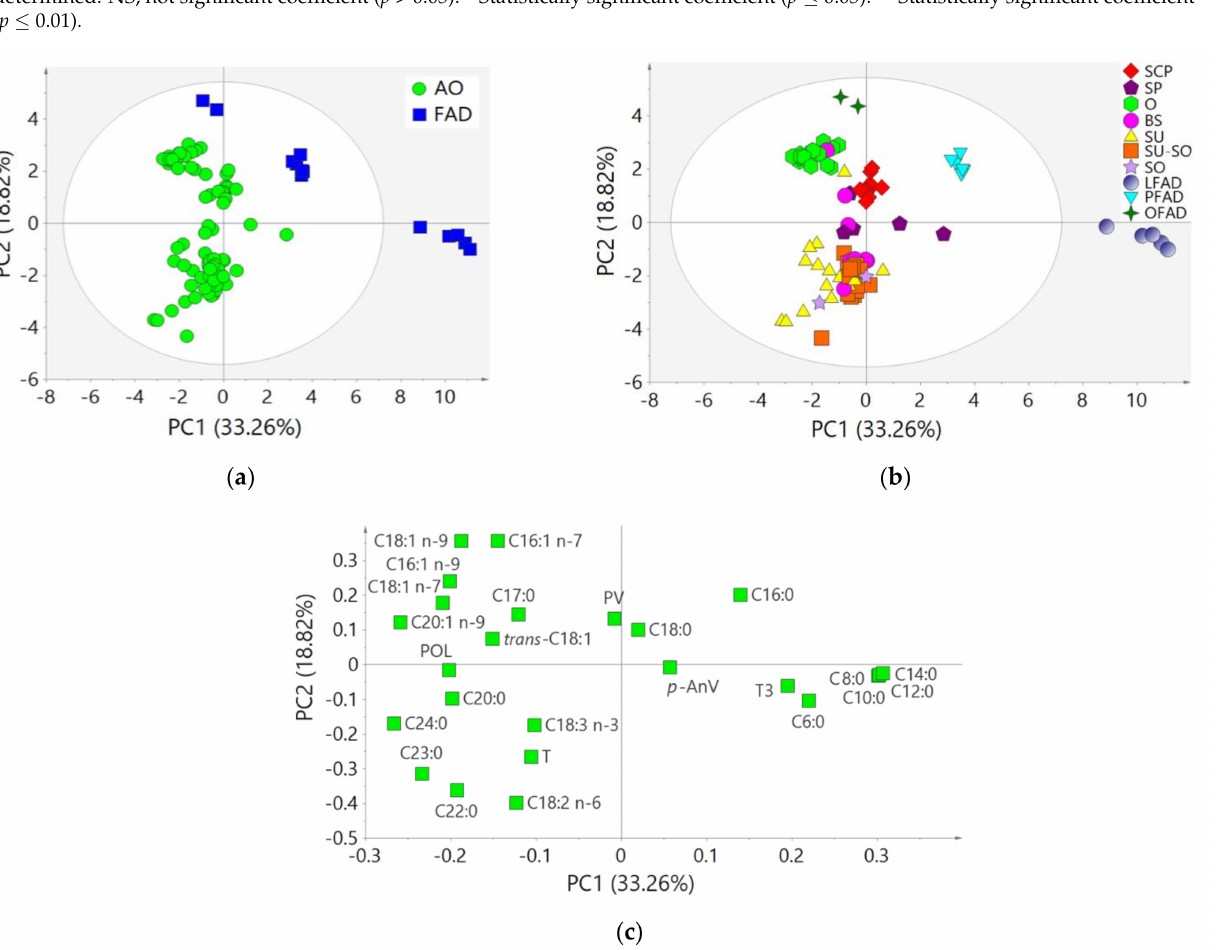
Figure 1. Principal component analysis (PCA) on the compositional and oxidation parameters (25 variables, mean-centered and scaled to unit variance) of acid oils from chemical refining (AO, n = 79) and fatty acid distillates from physical refining (FAD, n = 13). ( a ) Score plot colored according to the refining process, ( b ) score plot colored according to the botanical origin, and ( c ) loading plot. See Table 1 for